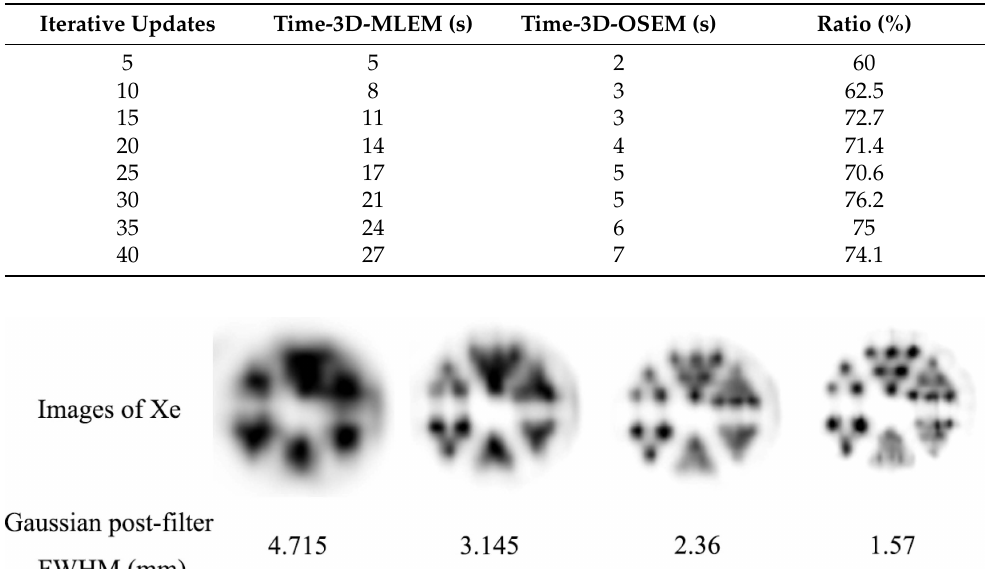
Table 3. Time required for different iterative updates of the 3D-MLEM and 3D-OSEM (5 subsets) algorithms.